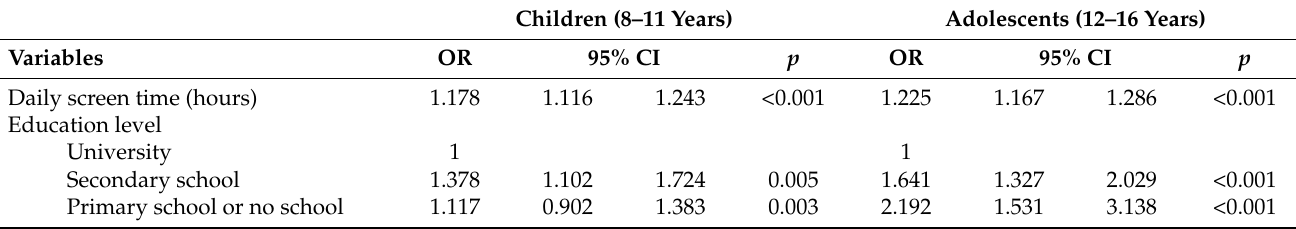
Table 4. Adjusted odds ratio (OR) and 95% confidence interval (CI) for the effects of screen time and parents’ education level on low or medium Mediterranean diet adherence (KIDMED index <